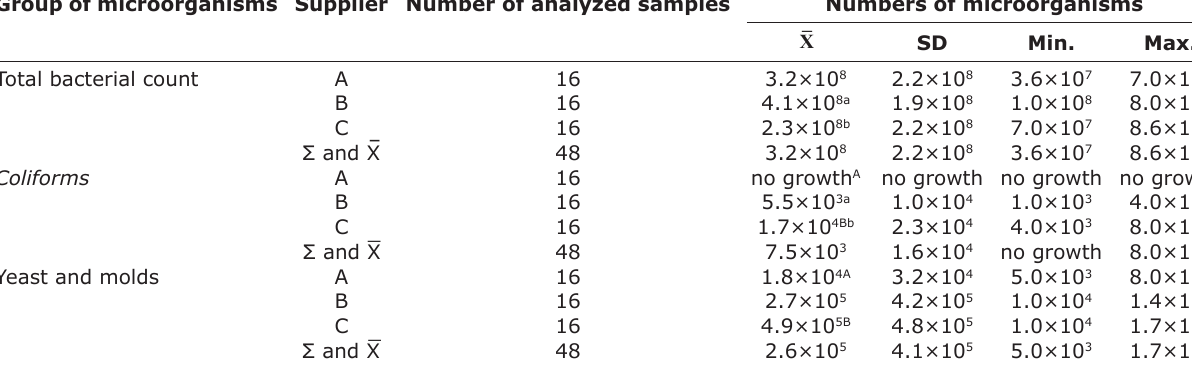
Table-2: Numbers of microorganisms detected in the curd cheese samples. Group of microorganisms Supplier Number of analyzed samples